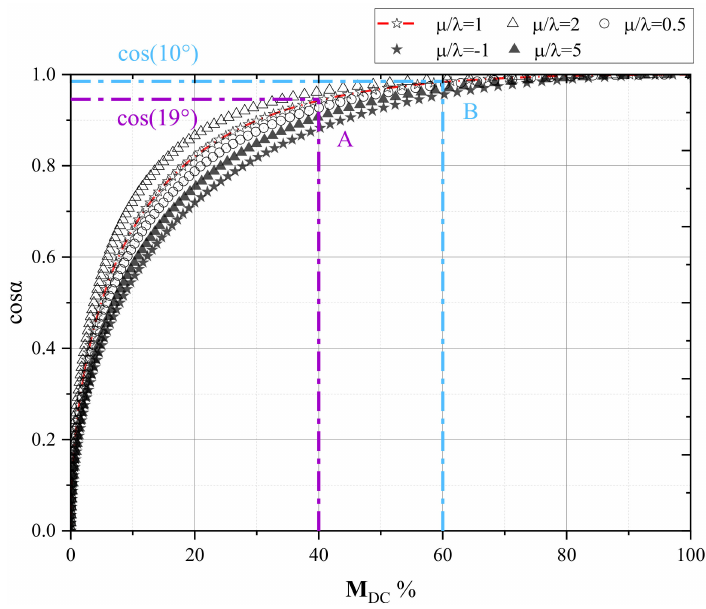
Figure 5. The relationship between M DC % and cos α for different µ / λ